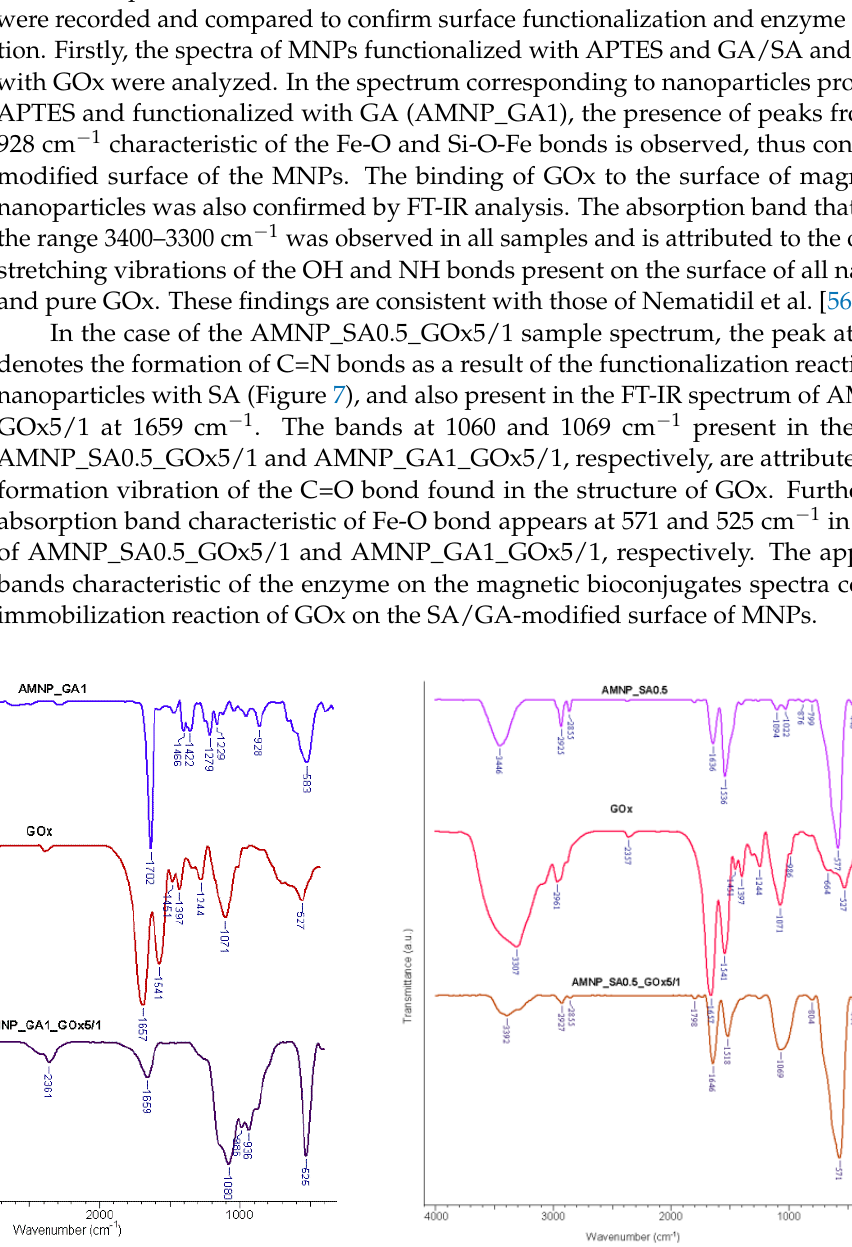
Figure 7. FT-IR spectra of AMNP_GA1 and AMNPSA0.5 before and after GOx immobilization.